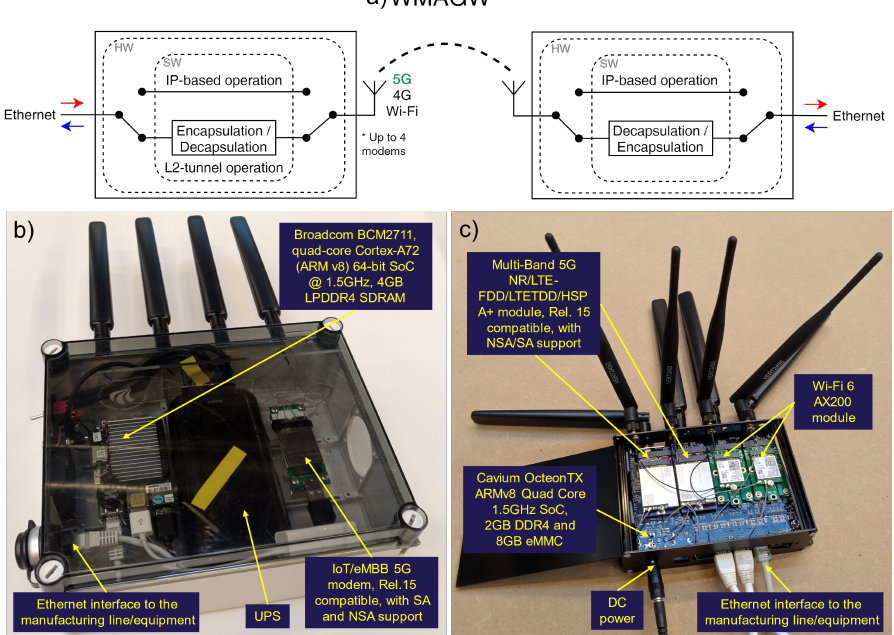
Figure 4. ( a ) Functional block diagram of the WMAGWs (operating in device-to-device L2-tunnel mode). Note: for IP-based operation, the alternative path is chosen via SW configuration. Infrastruc- ture mode is supported by using the exam same functional blocks. ( b ) Picture of the implemented WMAGW prototype (v2) including details on the different HW components. ( c ) Picture of the implemented WMAGW prototype (v3) including details on the different HW